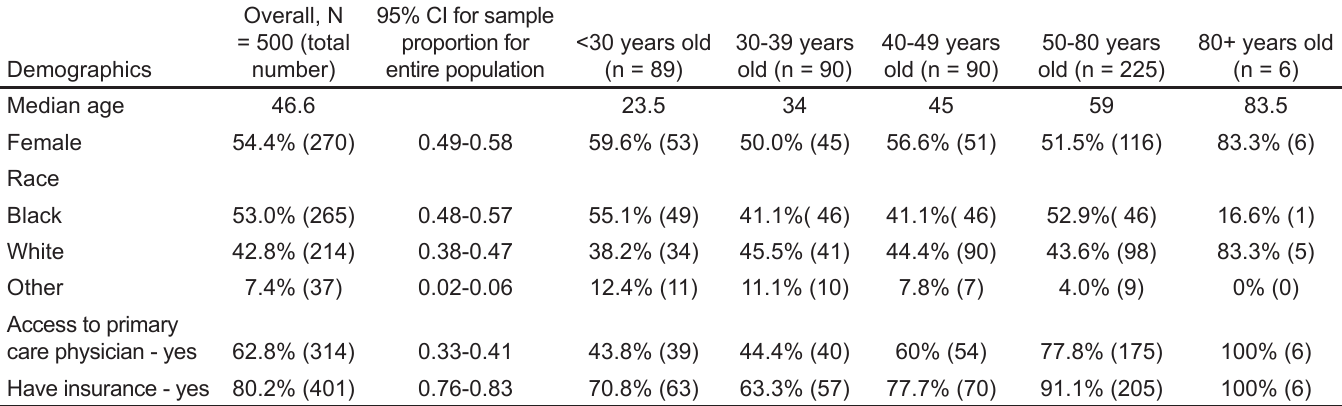
CI , confidence interval.